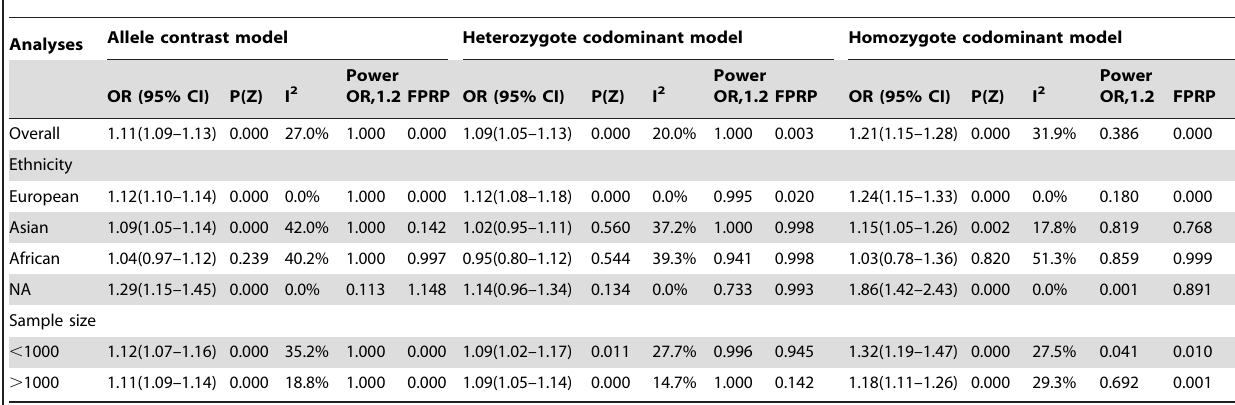
Table 2. Stratified analyses for MAP3K1 rs889312 polymorphism and breast cancer